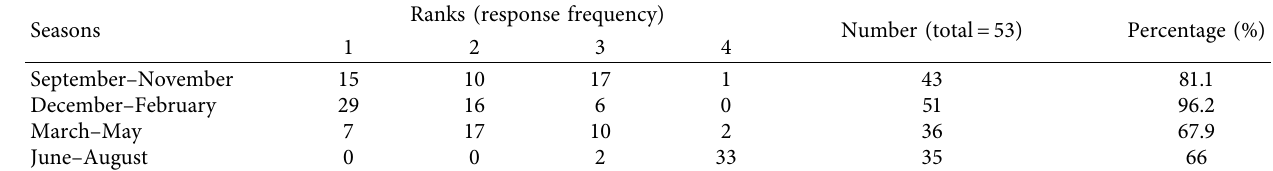
Table 3: Ranking seasons of conflict between humans and wild animals.